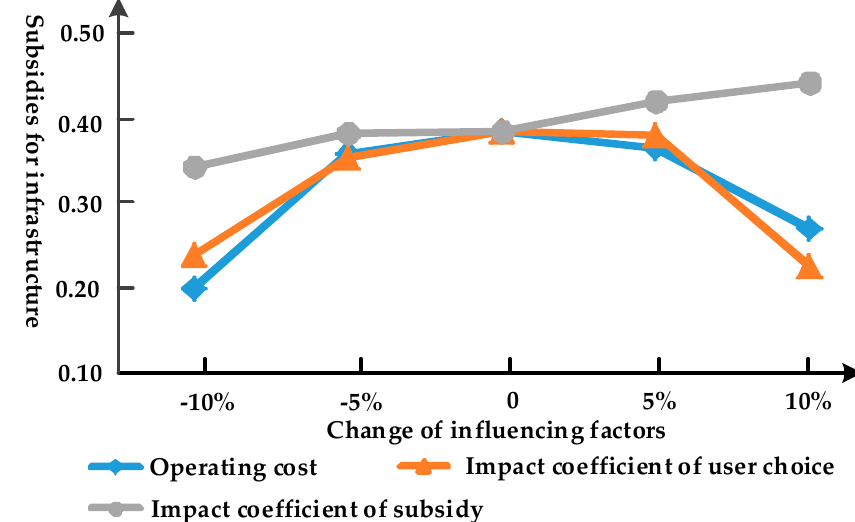
Figure 7. Curve of the subsidy rates of electric vehicles. Appl. Sci. 2019 , 9 , x